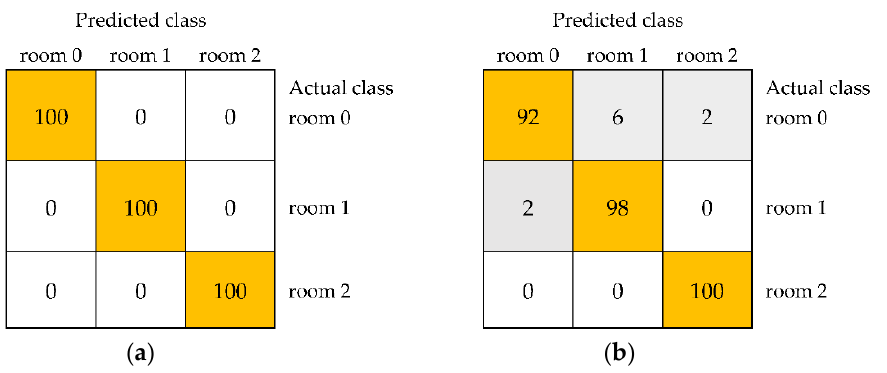
Figure 4. The confusion matrices of distinguishing unstored black currants (room 0) and fruit stored in the room for 1 week (room 1) and 2 weeks (room 2) using models including selected image textures from color space Lab built using the IBk ( a ) and JRip ( b ).